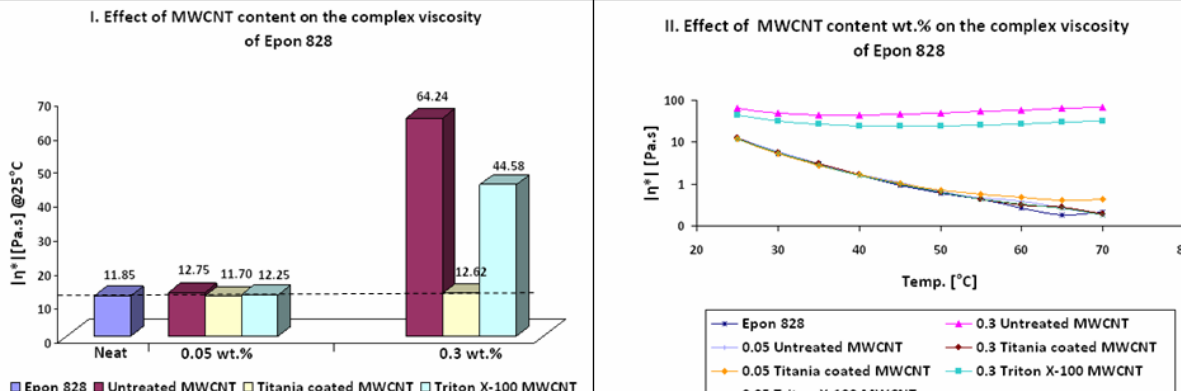
Figure 1. Effect of MWCNT content on the complex viscosity of Epon 828 before